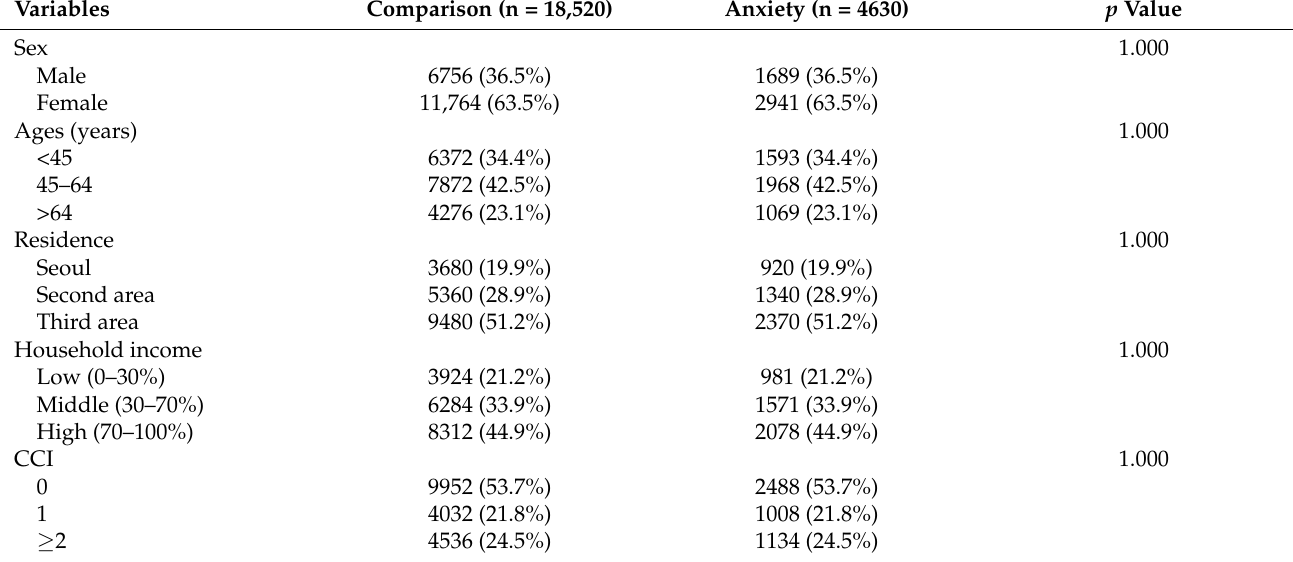
Table 3. Characteristics of the enrolled participants: comparison vs. anxiety